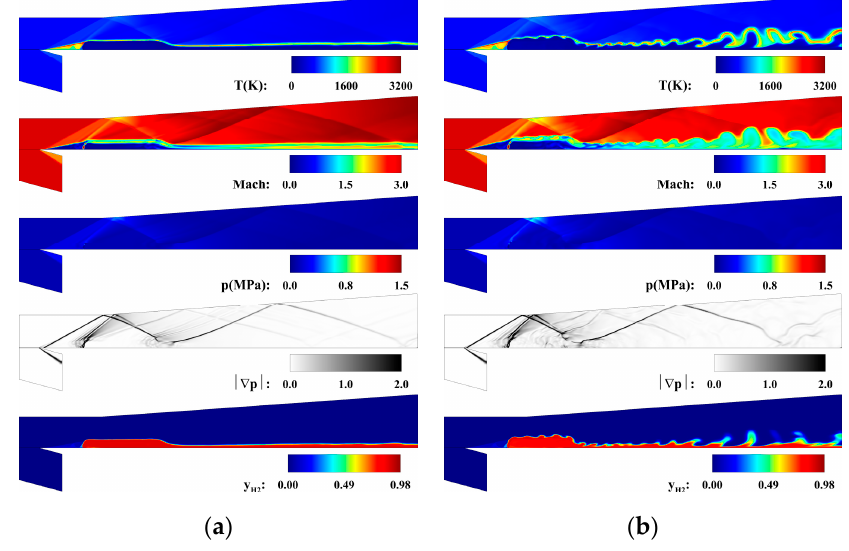
Figure 3. Instantaneous result for diverging nozzle combustor without cavity based on the injection pressures: ( a ) 0.75 MPa and ( b ) 1.00 MPa.